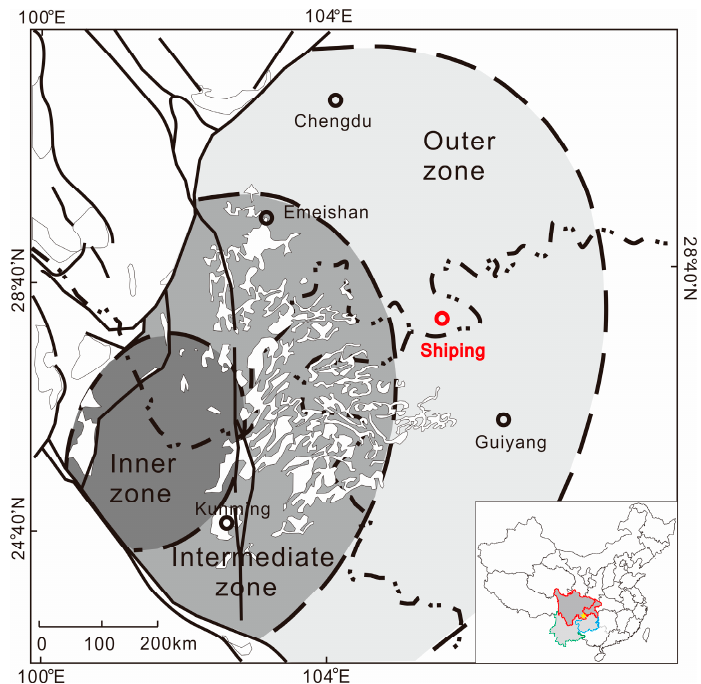
Figure 1. Distribution of Late Permian Emeishan basalts in southwestern China [13].